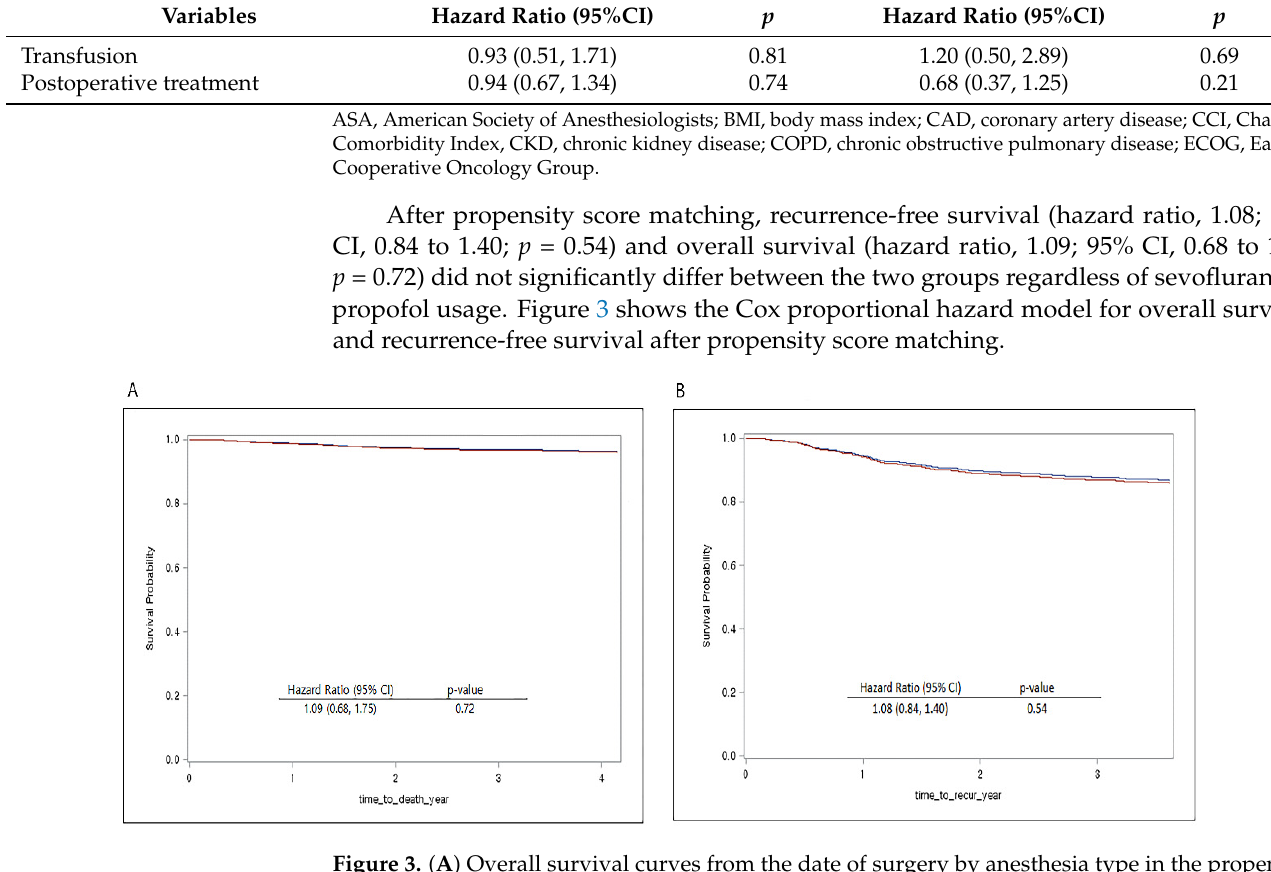
Figure 3. ( A ) Overall survival curves from the date of surgery by anesthesia type in the propensity score matched cohort. ( B ) Recurrence-free survival curves from the date of surgery by anesthesia type in the propensity score matched cohort. (red line: propofol received, blue line: sevoflurane re- ceived).